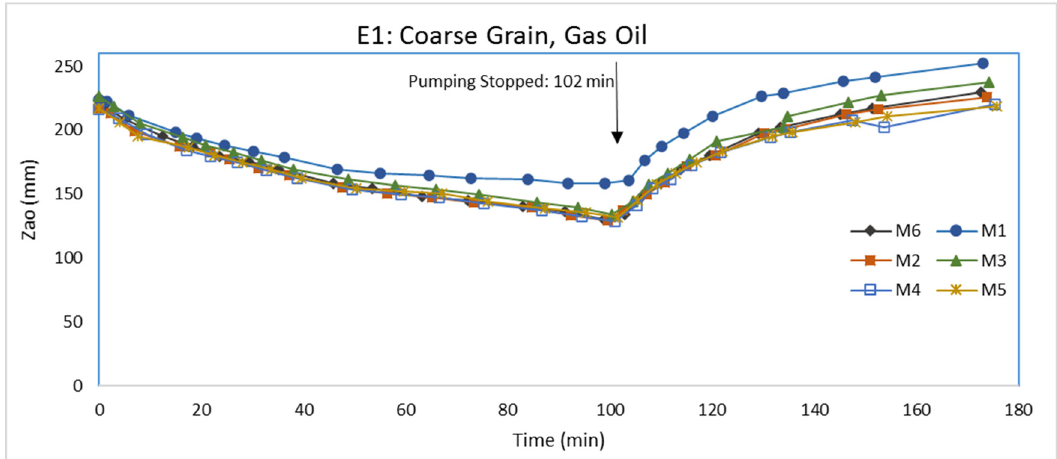
Figure 4. Air-LNAPL interface elevation (Zao) variations in E1.